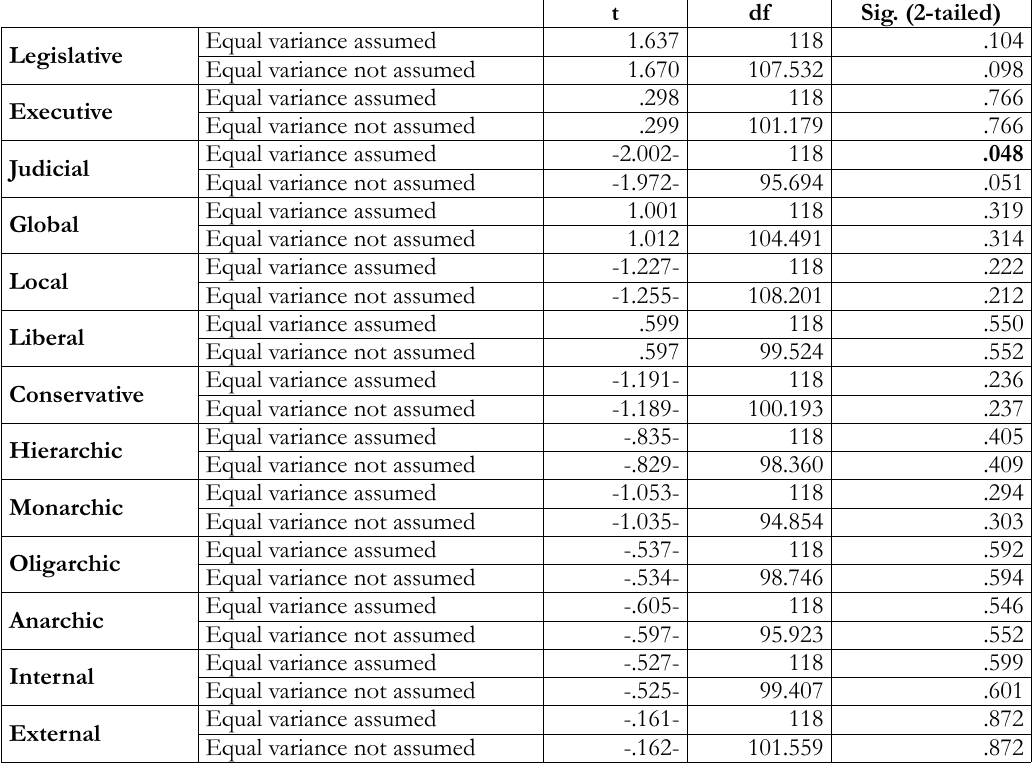
Table 3. Test of independent